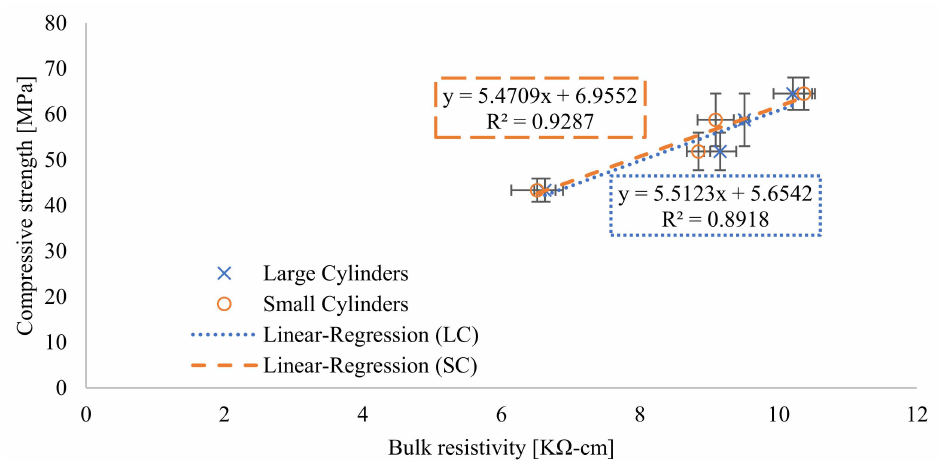
Figure 6. Linear regression analysis of the relationship between bulk electrical resistivity and com- pressive strength (LC = Large Cylinders, SC = Small Cylinders).